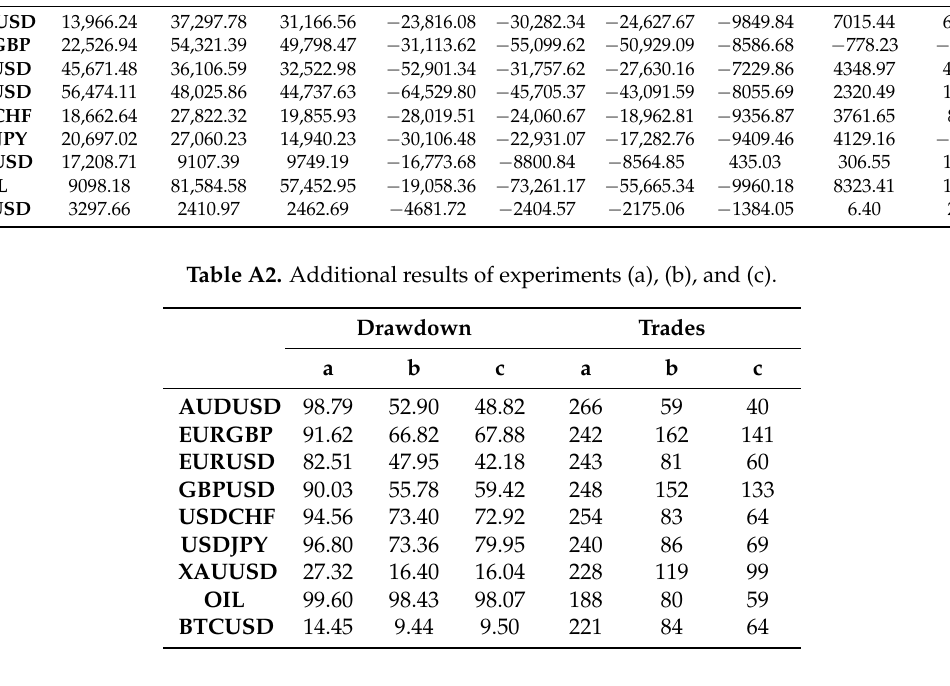
Table A3. Results of experiment (d) for various values of N.